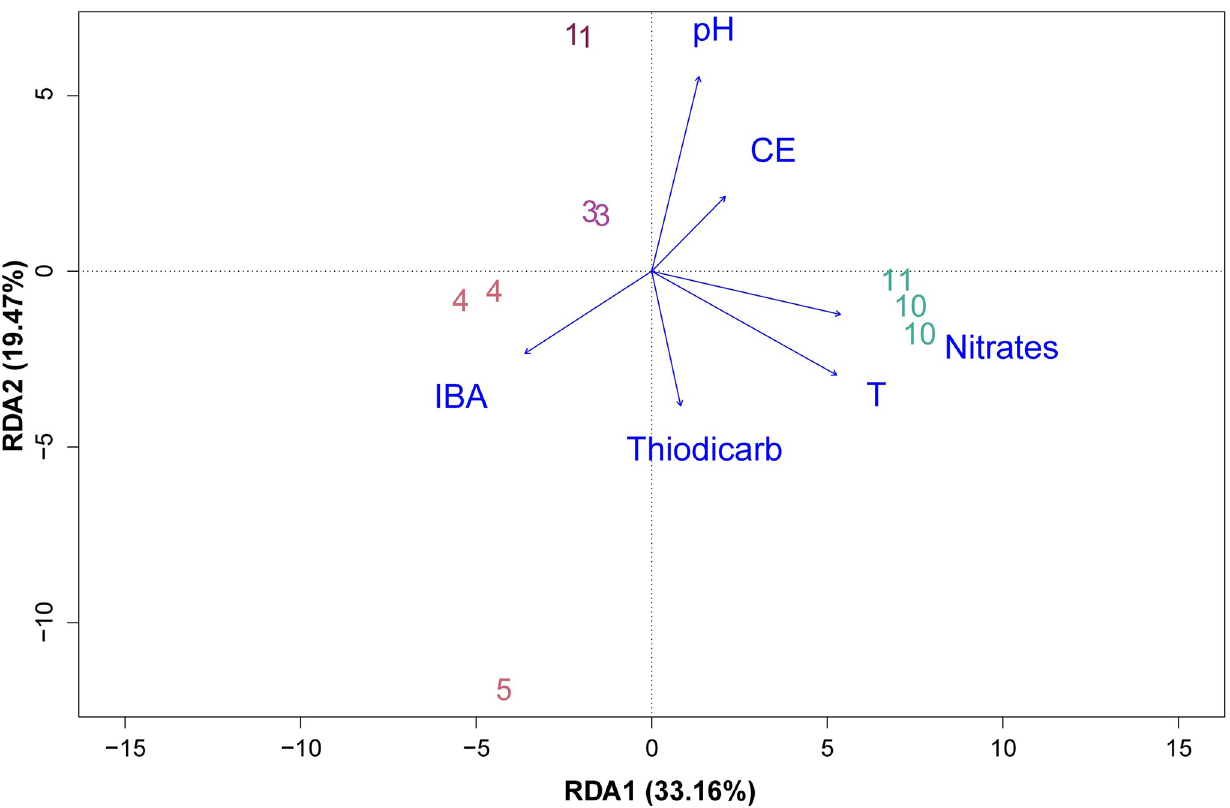
Fig 6. Redundance analysis (RDA) between species with environmental factors. Samples are numbered according to the information in Fig 1. Environmental data was taken from Ref. 34. T: Temperature, EC: Electrical conductivity. IBA: 3-indolebutyric